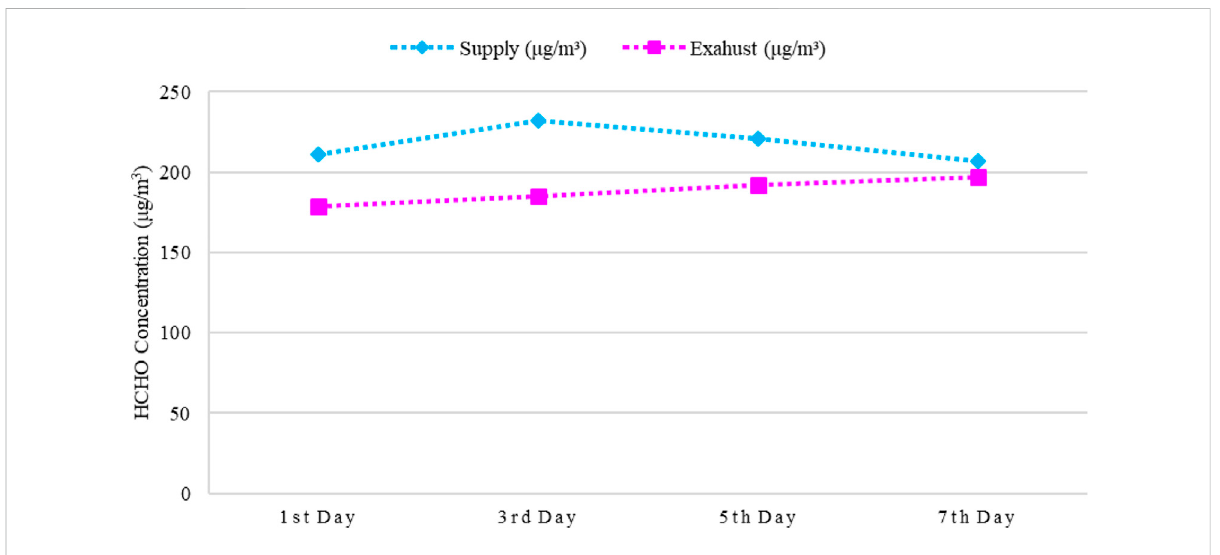
FIGURE 3 HCHO Adsorption Test Result (Normal wallpaper with 0